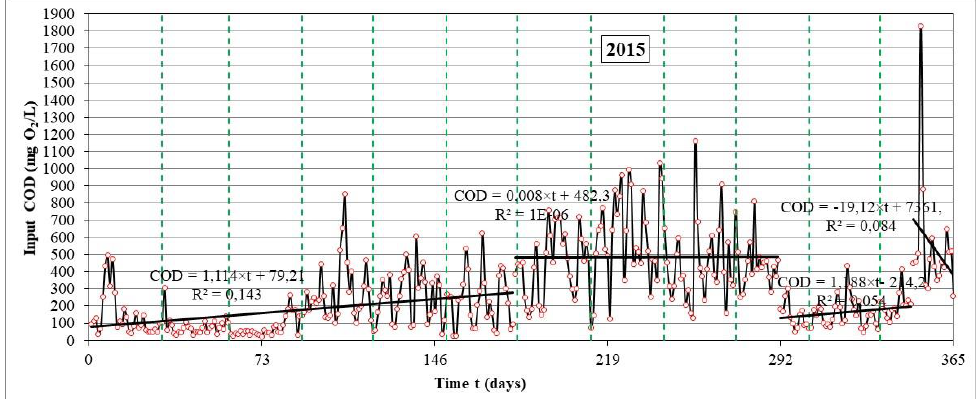
Figure 3. RAPS of the input COD for year 2015.